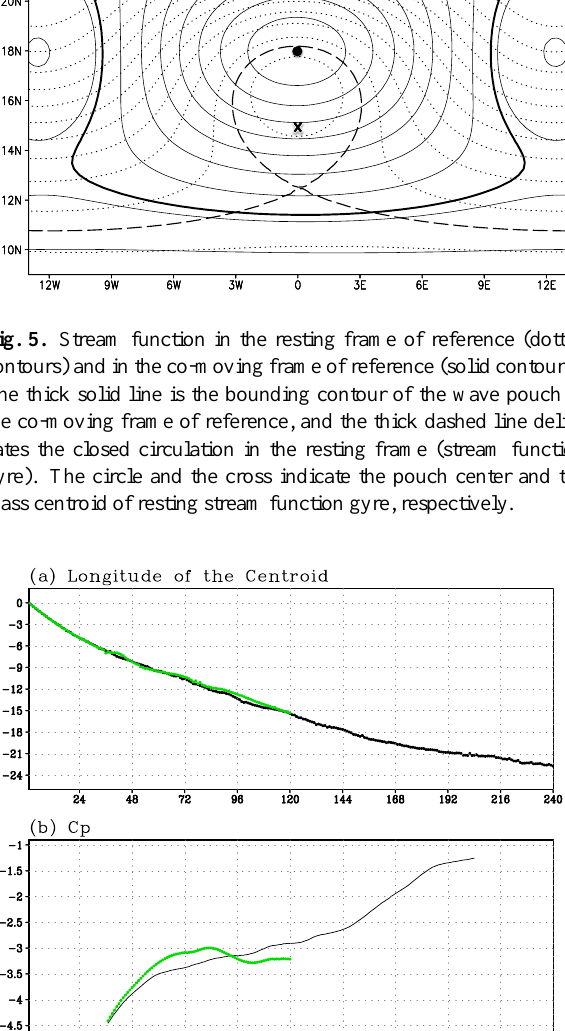
Fig. 6. (a) The longitude of the mass centroid and (b) the propagation speed of the gyre-pouch based on its vorticity centroid as described in the text. The black curves represent the coarse-resolution simulation, and the green curves represent the warm-rain experiment. The abscissa is time (h). The ordinate is longitude in (a) and propagation speed (ms − 1 ) in (b).